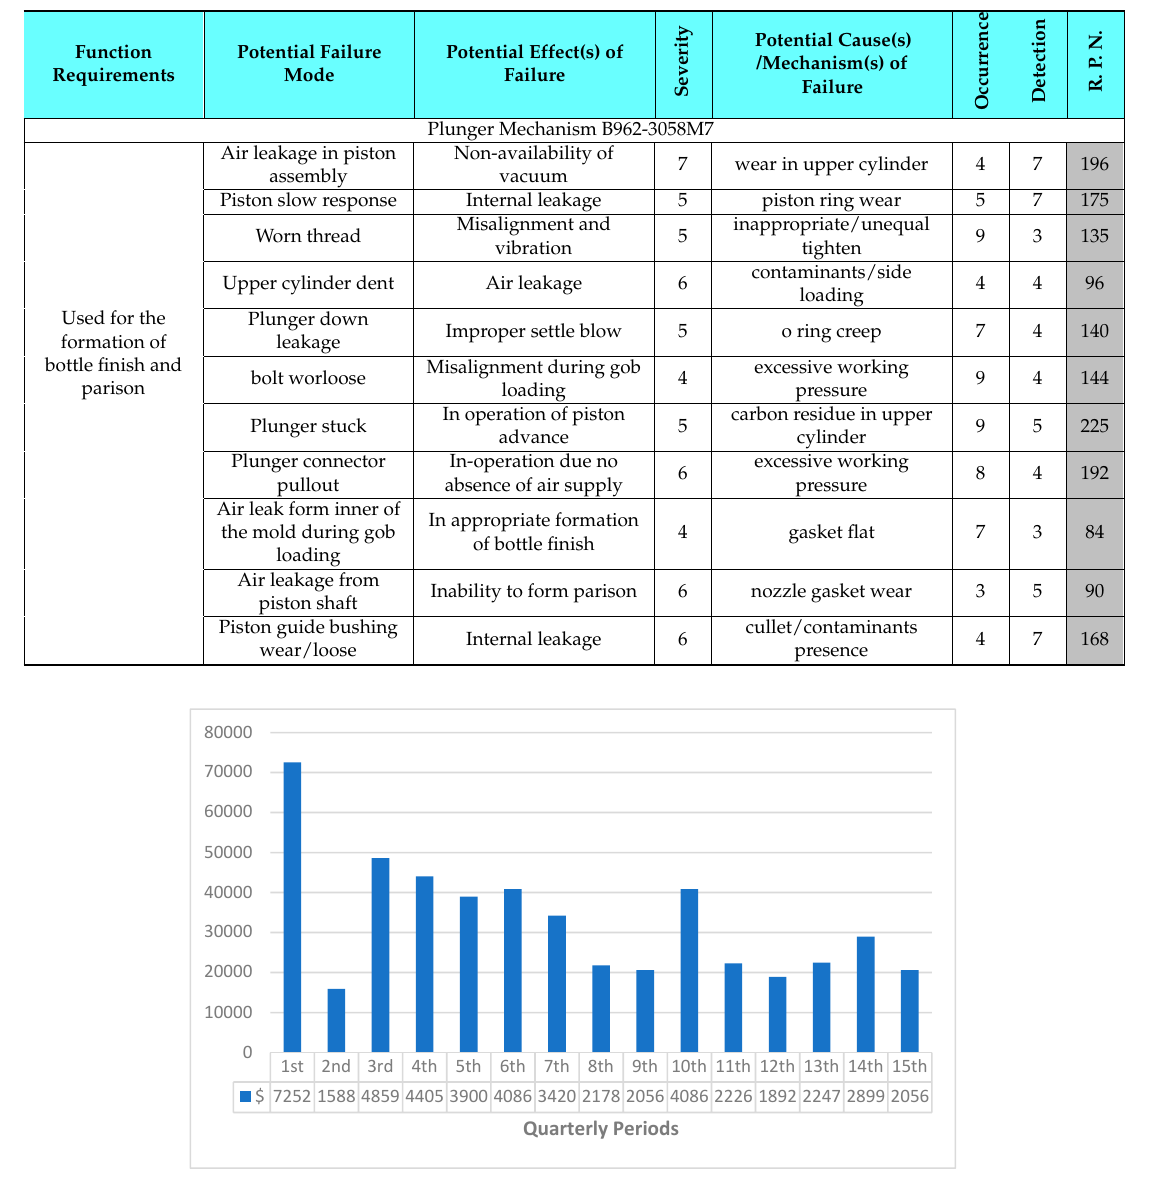
Table 7. Computation of FMEA for the plunger mechanism.